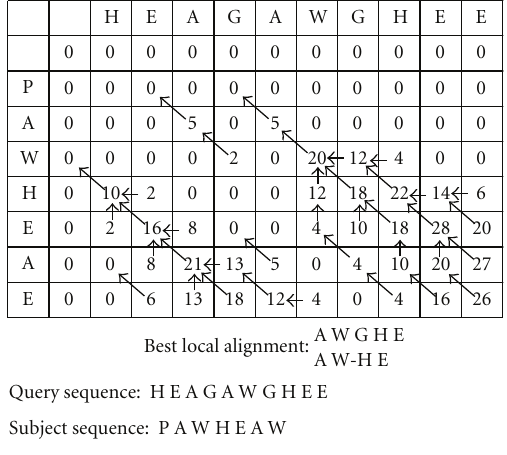
Figure 3: Illustration of the Smith-Waterman